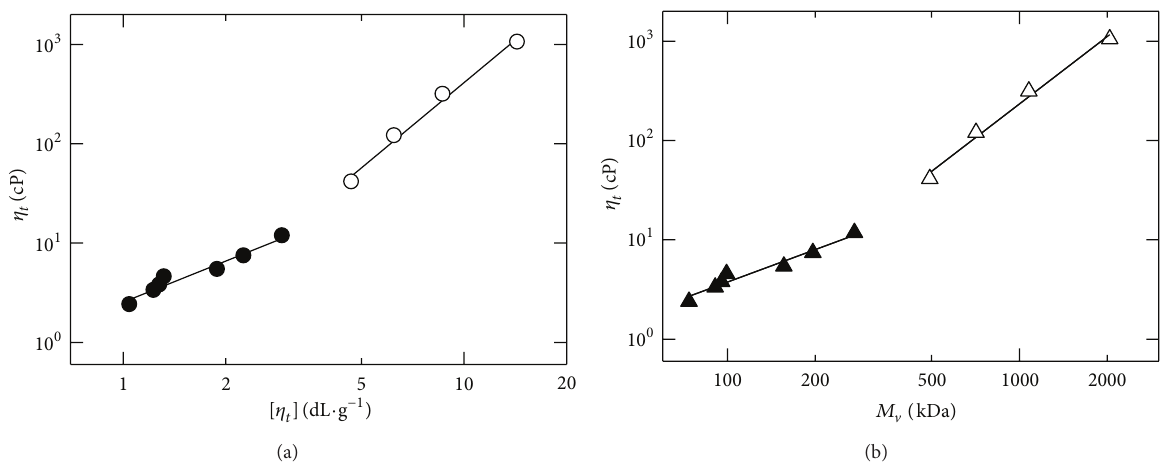
Figure 8: (a) Viscosity of reaction mixture at time 𝑡 , 𝜂 𝑡 , versus intrinsic viscosity of resulting fragment, [𝜂 𝑡 ] ; (b) viscosity of reaction mixture at time 𝑡 , 𝜂 𝑡 , versus viscosity-average molecular weight of resulting fragment, 𝑀 V , for fragmentation of 1.0% (w/v) chitosan solution by 0.5 N HCl at 65 ∘